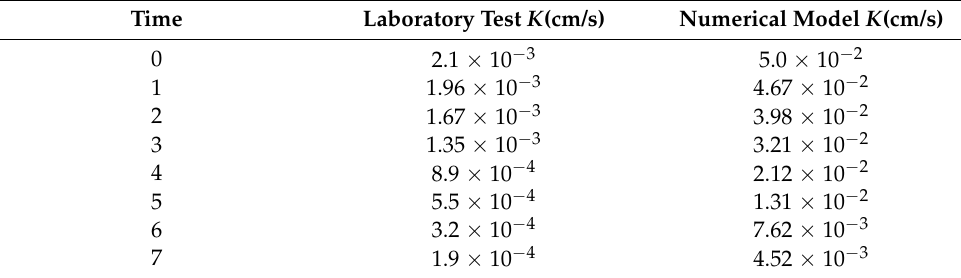
Table 7. Hydraulic parameters of different time